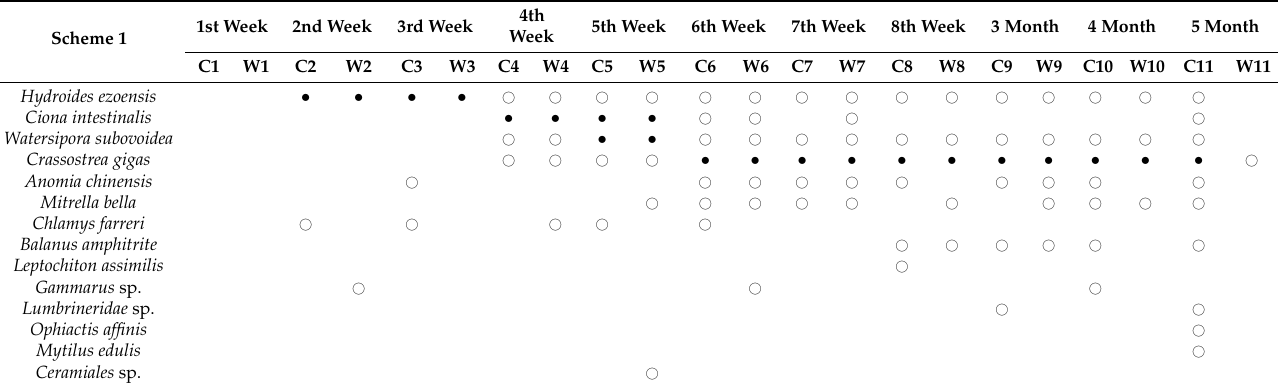
Table 1. Presence of macrobenthos on the artificial reef